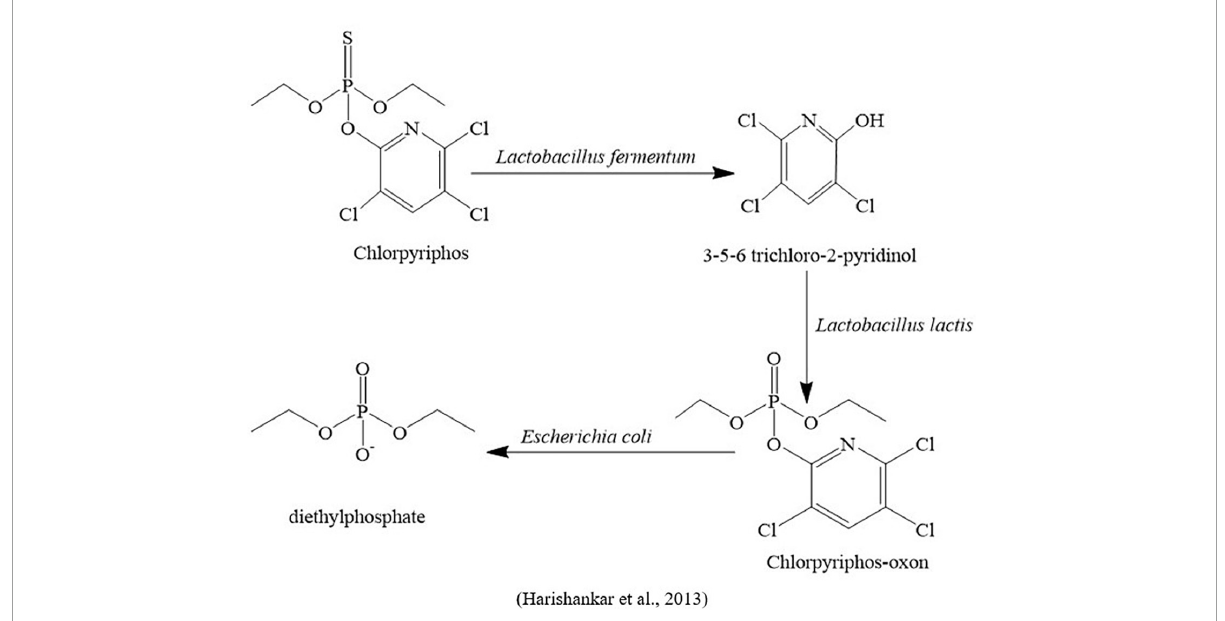
FIGURE5 Microbial metabolic pathway of chlorpyriphos degradation by insect gut